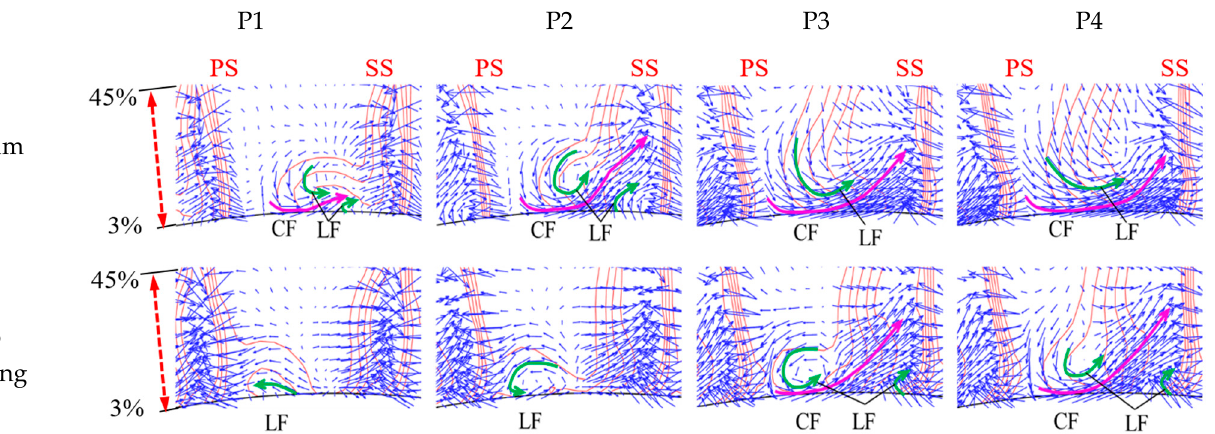
Figure 37. Distribution of secondary flow velocity vector at the stator outlet.